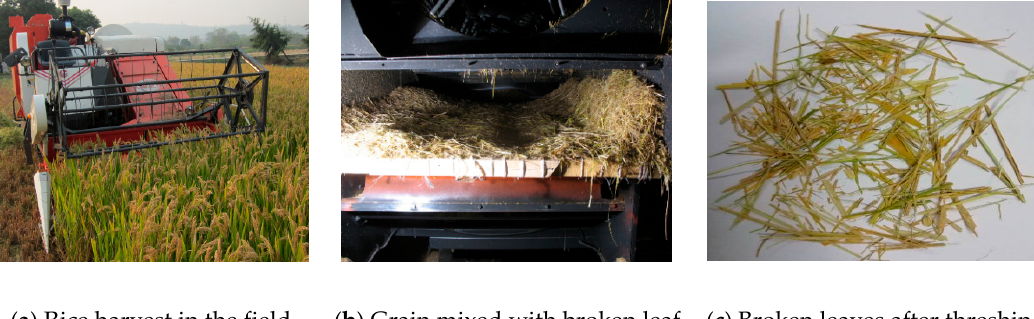
Figure 1. Natural rice and high impurity content after threshing by combine harvester.